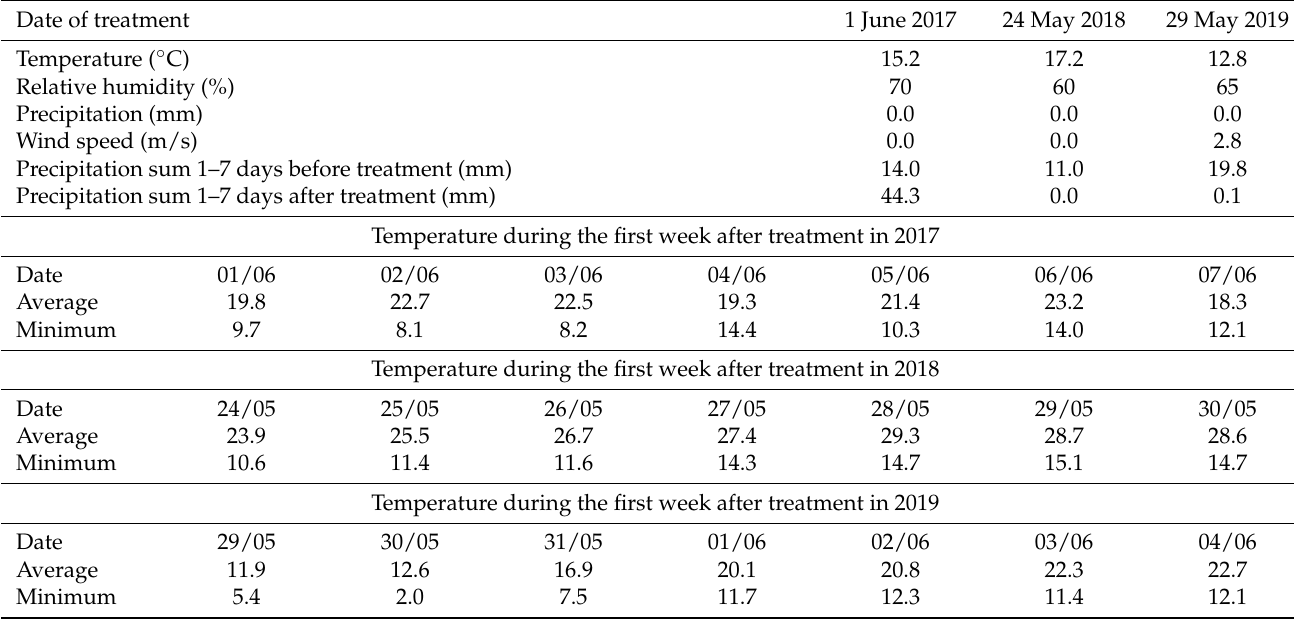
Table 6. Tested and standard adjuvants applied in the field experiments in